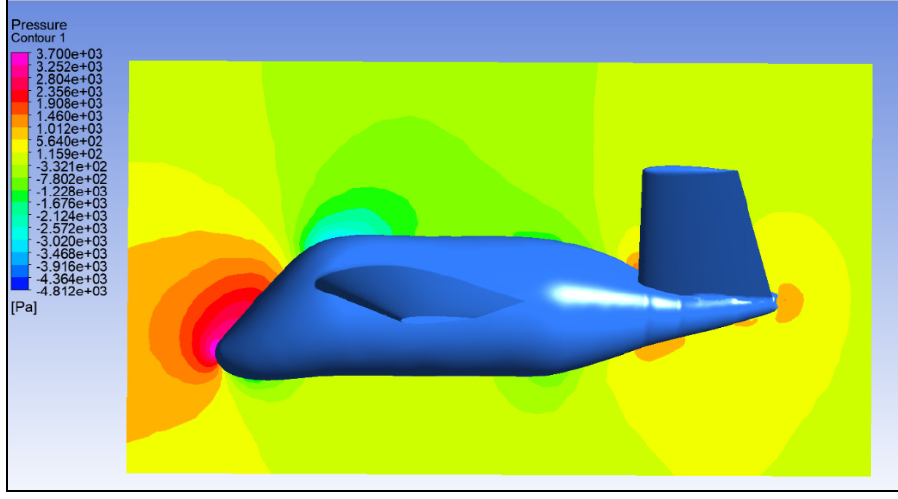
Figure 28. Static pressure contour at plane XZ.